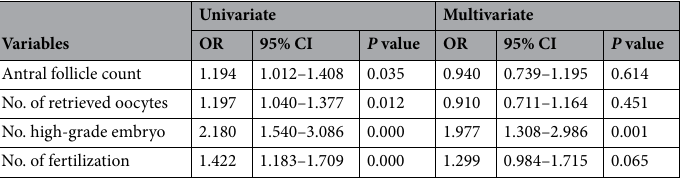
Table 2. Univariate and multivariate regression analysis. OR odds ratio, AFC antral follicle count in both ovaries, CI confidence